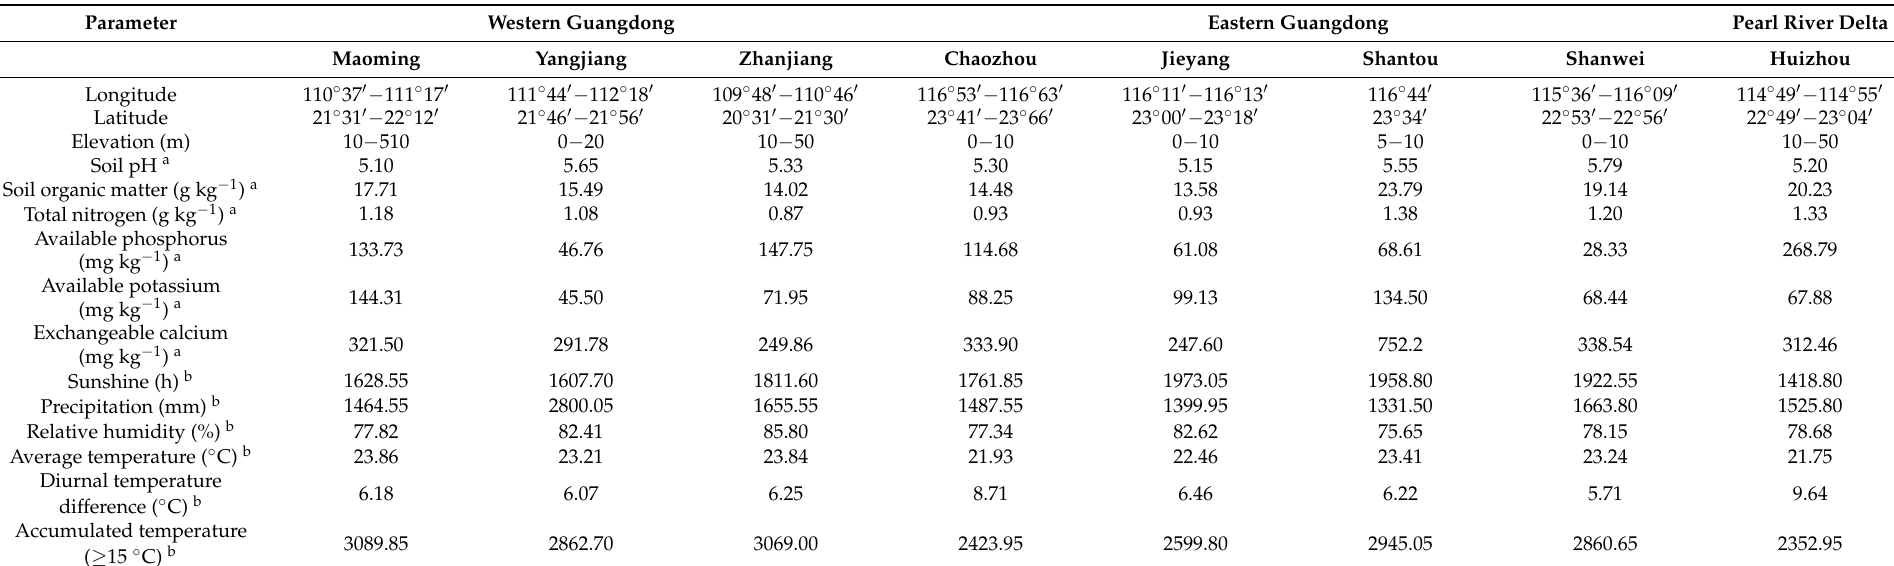
Table 1. Location, soil, and climate characteristics of sampled farms for sweet potato production in this